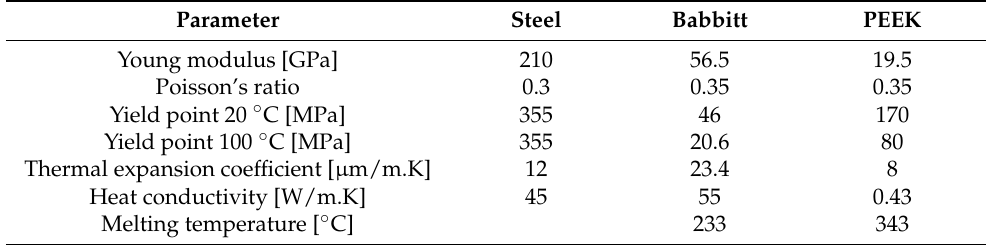
Table 2. Material